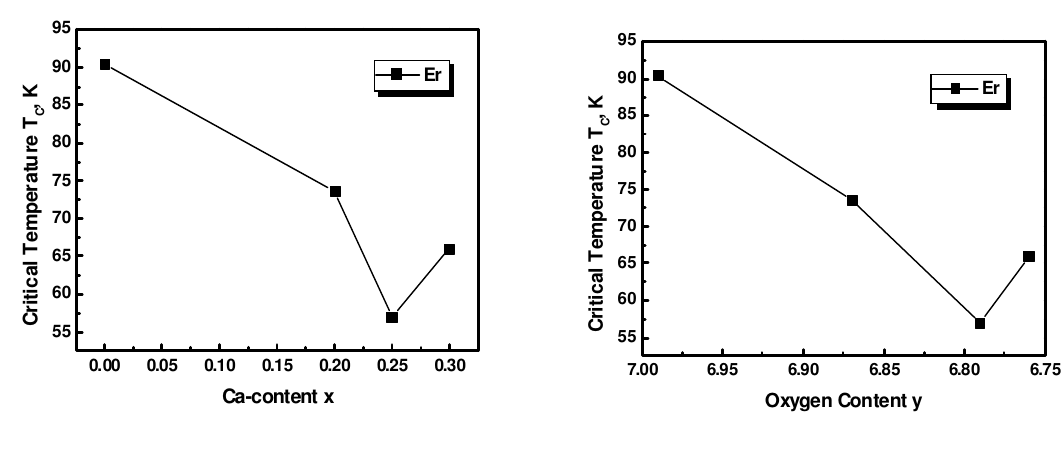
Fig. 4 The critical temperature (T c ) dependence from the Ca-content (x) and the oxygen content (y) in Er 1 − x Ca x Ba 2 Cu 3 O y .